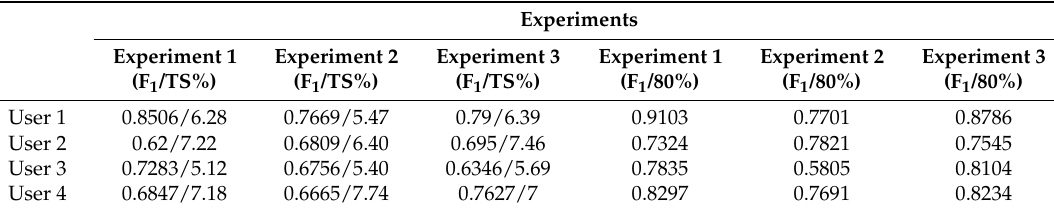
Table 11 . F (cid:2869) score for data fused from IMU and 3-axial acceleration sensors. Table 11. F 1 score for data fused from IMU and 3-axial acceleration sensors. Experiments